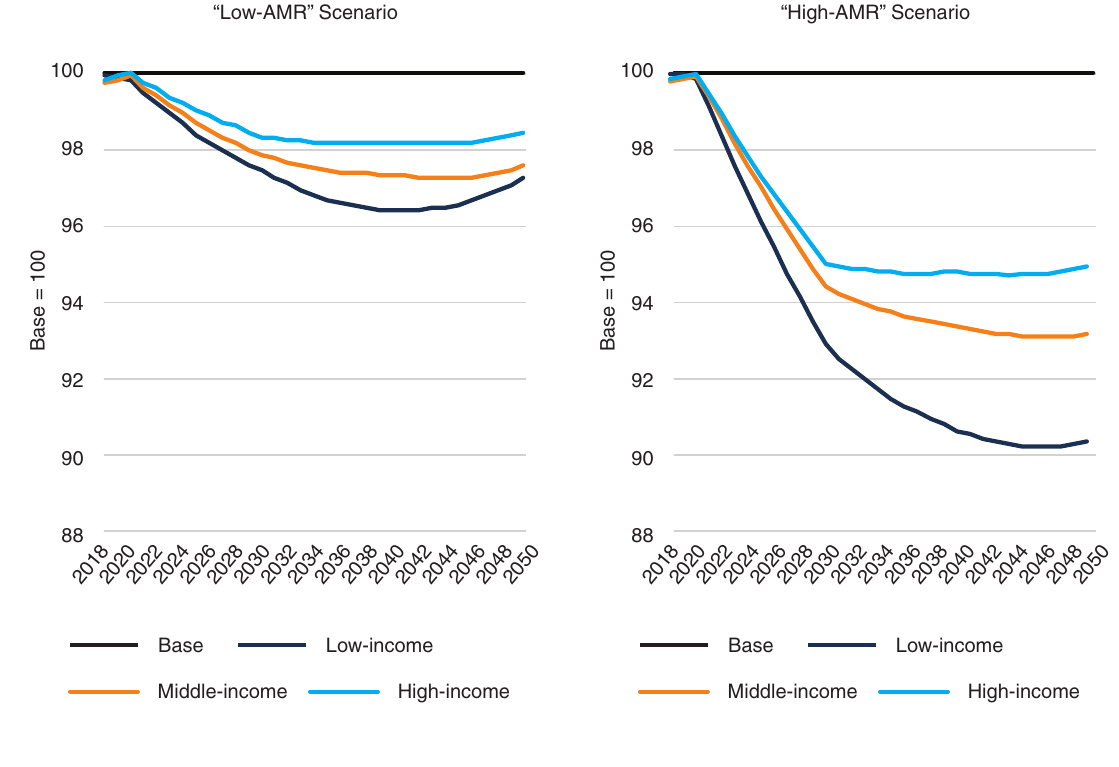
FIGURE 6. Health Care Costs Reach Nearly $1.2 Trillion in the “High-AMR”